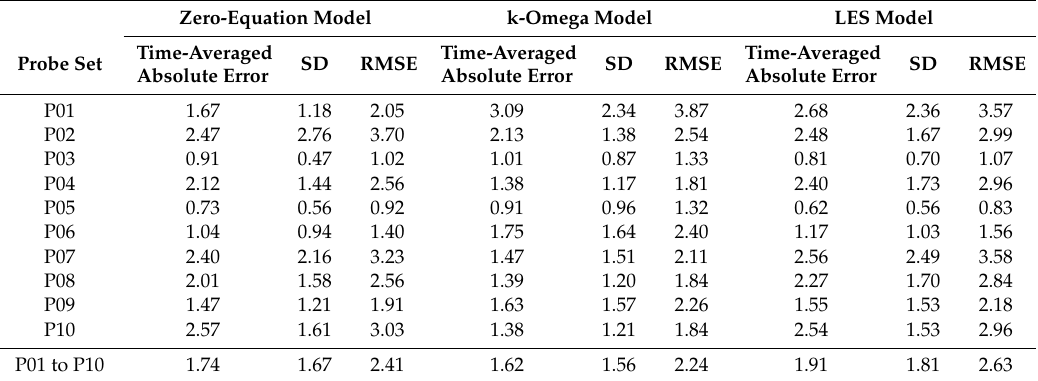
Table 4. Time-averaged absolute errors, standard deviations, and root-mean-square errors (RMSE), in